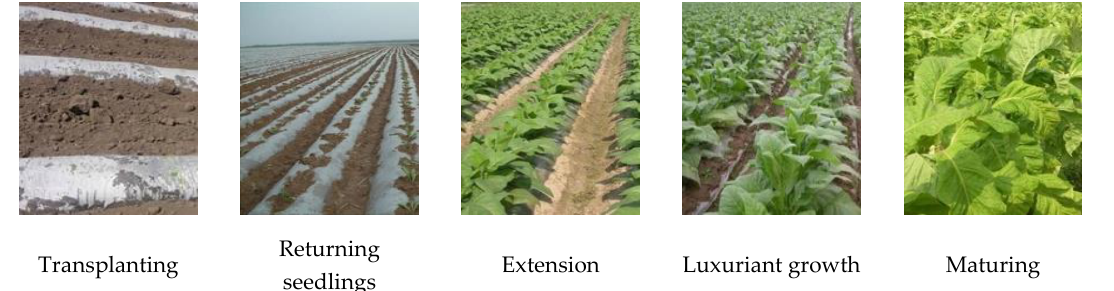
Figure 2. Flue-cured tobacco images during the field period.